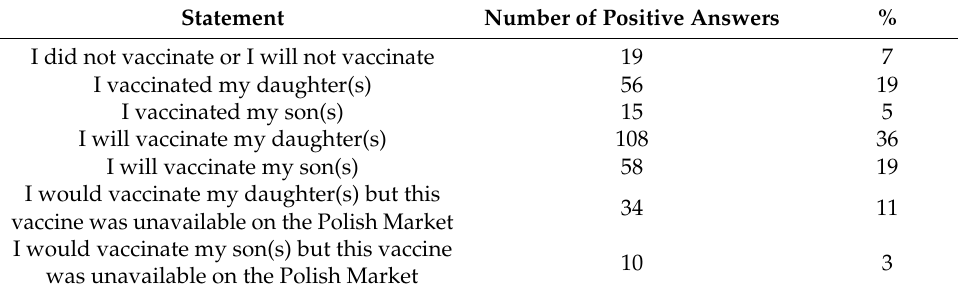
Table 7. Doctors’ individual approach towards HPV implementation for their own child.